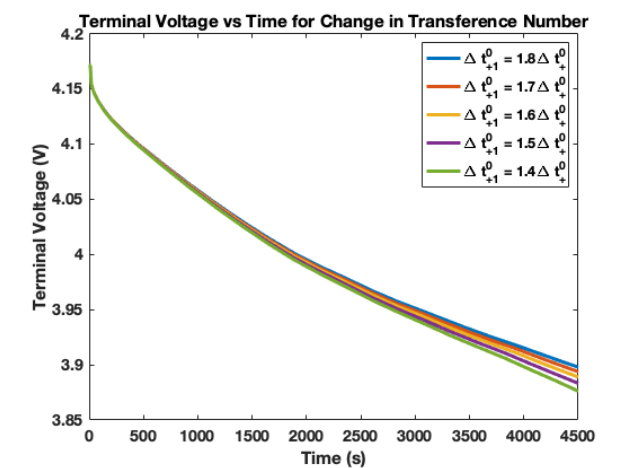
Figure 9. Terminal voltage vs. time for change in transference number from 1.8 to 1.4.